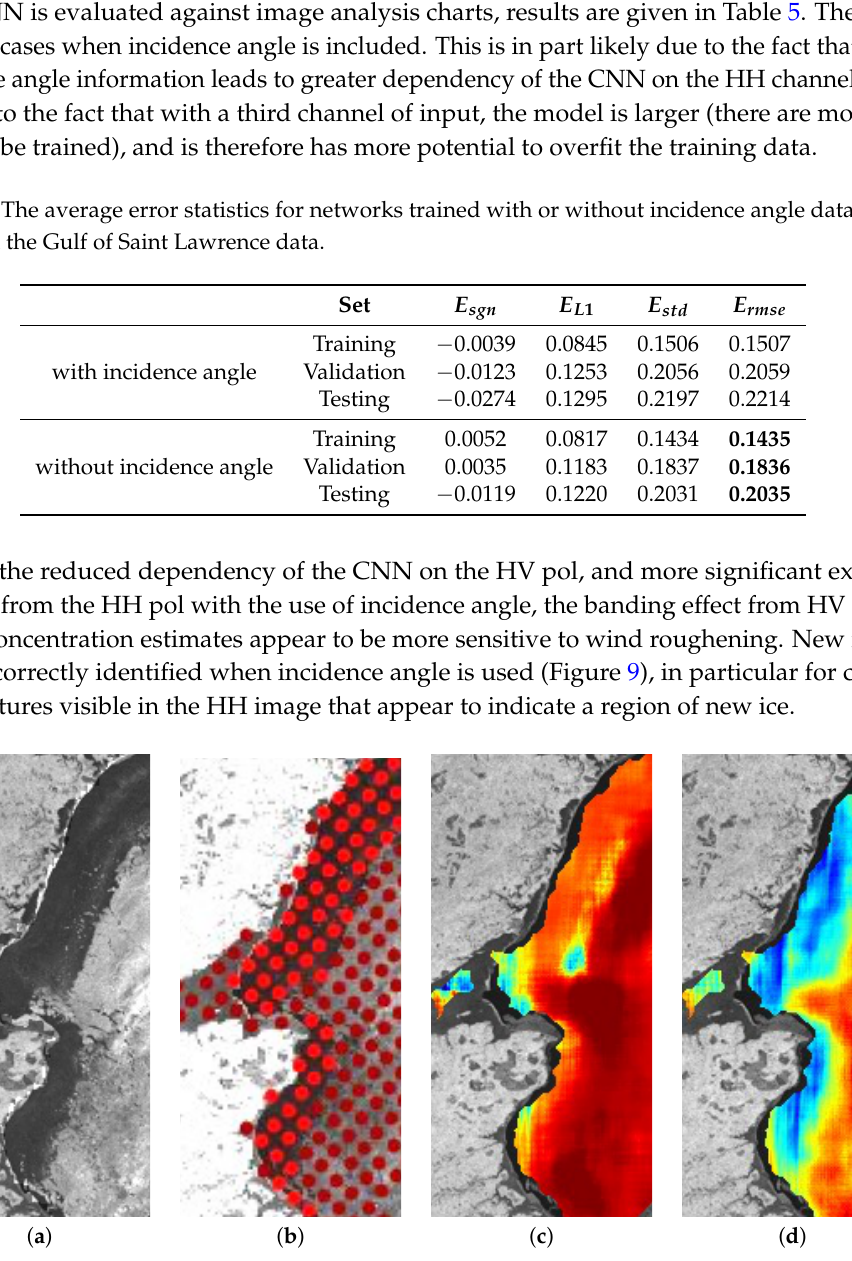
Figure 9. New ice can be seen in the HH image as the dark regions along the coast ( a ). This ice is correctly identified when incidence angle data are used ( c ), as compared to when the incidence angle data is not used ( d ). Subscene of dimension 120 km × 52 km from 20140206_221744 centered at 47.12 ◦ N, 64.72 ◦ W. Image analysis is shown in panel ( b